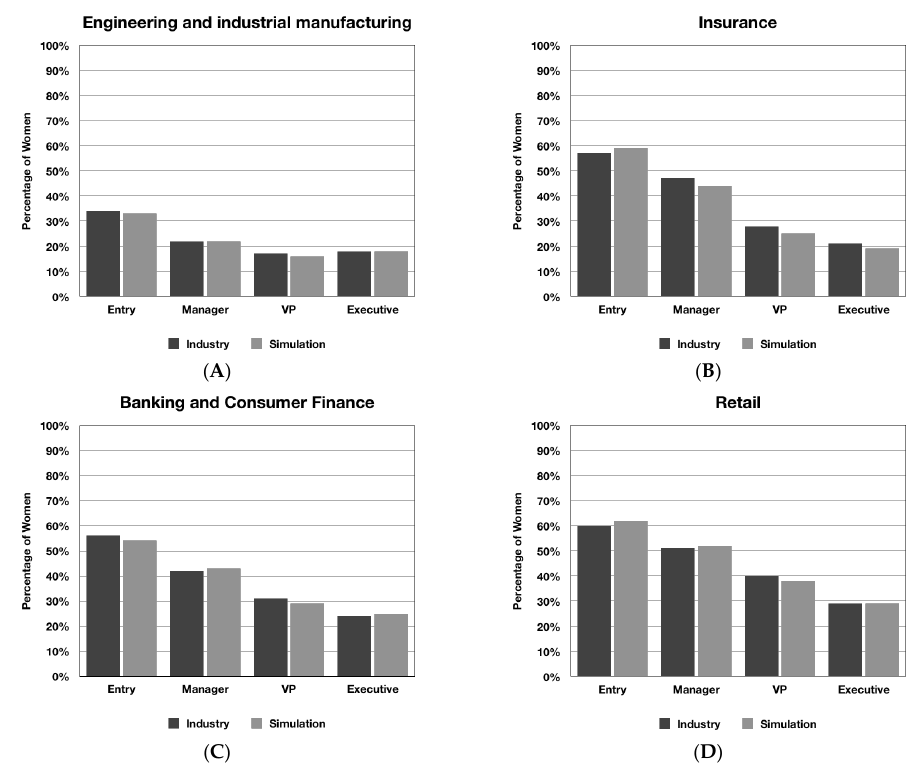
Figure 6. Simulating the gender imbalances of different industries by adjusting both promotion and hiring biases. In each chart, each dark bar is a data point from the 2018 McKinsey and LeanIn Women in the Workplace report, while each light bar is a data point generated by our simulation.